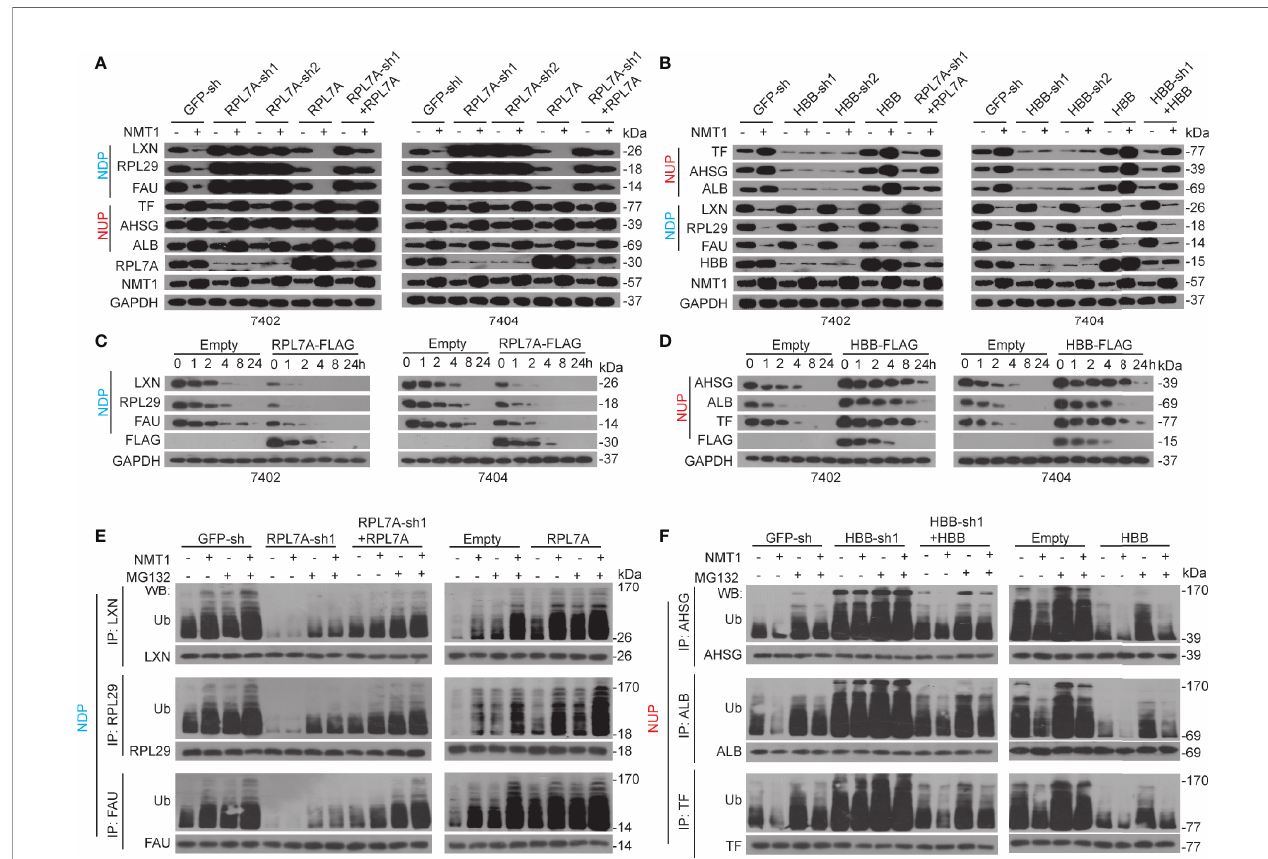
FIGURE 5 | RPL7A/HBB controlled NDP/NUP expression via ubiquitination. (A) RPL7A was essential for NMT1-reduced NDP. The expression of NDP/NUP in control cells, Bel-7402 and Bel-7404 cells with RPL7A knocked down or overexpressed, in the absence or presence of NMT1 overexpression, as measured by WB. (B) HBB was essential for NMT1-indudced NUP. The expression of NUP/NDP in control cells, Bel-7402 and Bel-7404 cells with HBB knocked down or overexpressed, in the absence or presence of NMT1 overexpression, as measured by WB. (C, D) RPL7A and HBB oppositely regulated half-life of NDP and NUP. CHX-chase experiments were performed in Bel-7402 and Bel-7404 cells with or without overexpression of RPL7A (C) or HBB (D) . (E, F) RPL7A/HBB oppositely controlled ubiquitination of NDP/NUP. Ubiquitination of NDP (E) and NUP (F) in Bel-7402 cells was measured by fi rstly immuno-precipitation of NDP/NUP by corresponding antibodies, as indicated, followed by WB using anti-Ub antibodies. Cells with or without knocked down or overexpressed with RPL7A (E) or HBB (F) were simultaneously treated with or without overexpression of NMT1. MG132 was treated at a fi nal concentration of 25µM. Images of WB are representative ones of 3 independent